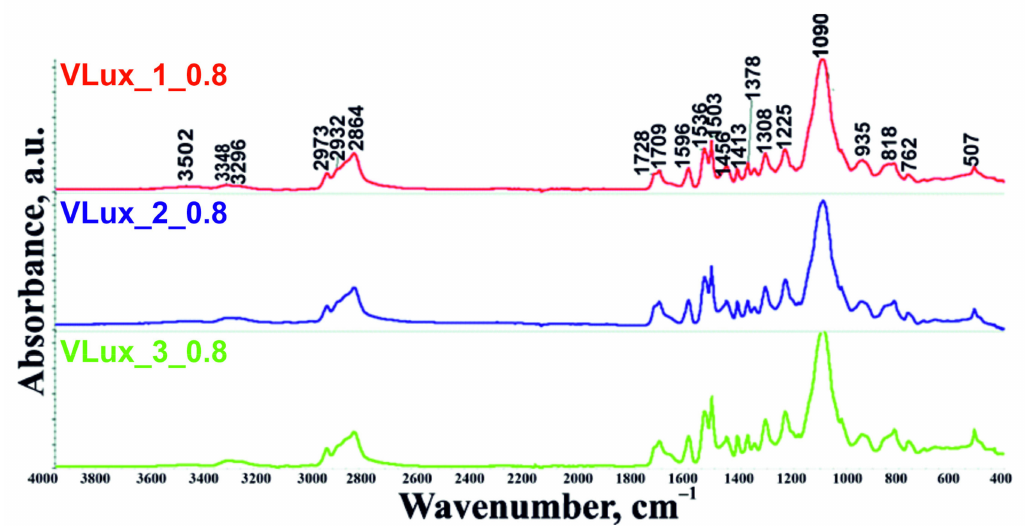
Figure 3. Comparison of ATR-FTIR spectra for foams with different water content at INCO =